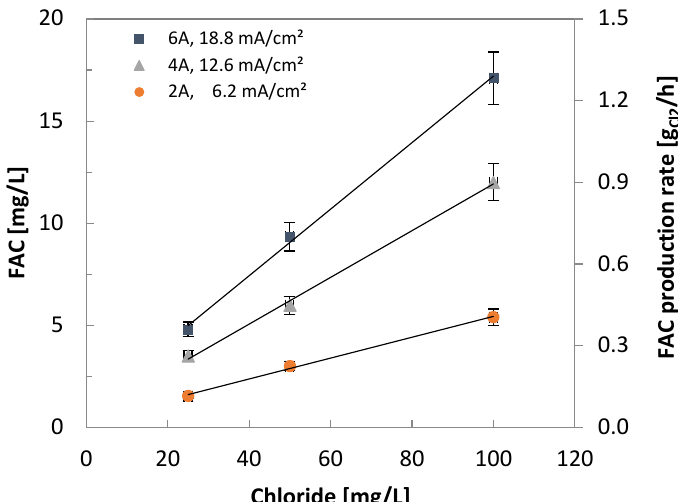
Figure 5. Relation between chloride concentration and FAC concentrations ( n = 9) (Q = 75 L / h, EC = 400 µ S / cm, T = 19 ± 1 ◦ C).